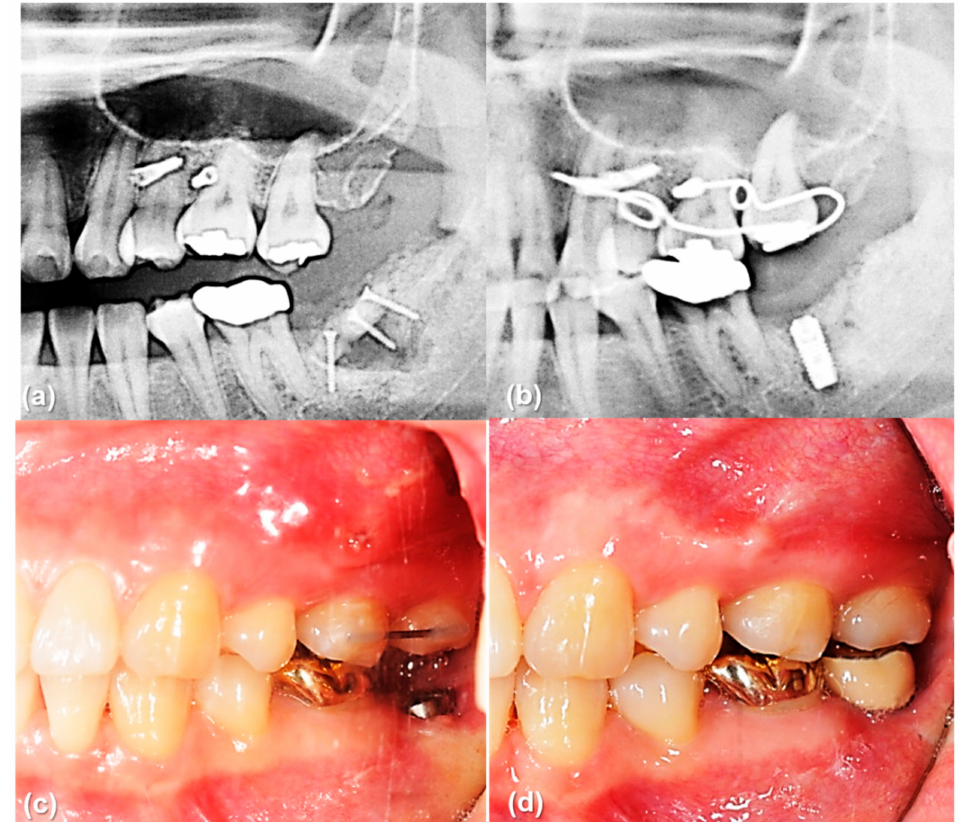
Figure 10. The orthodontic miniscrew supported the counterclockwise rotational force in a patient with extruded upper left second molar: ( a ) Pretreatment panoramic radiograph shows extrusion of upper left second molar. ( b ) Posttreatment panoramic radiograph shows sufficient intrusion of upper left second molar after six months of treatment. Dental implant was placed in the lower left second molar area. ( c , d ) Intraoral photographs before and after implant crown